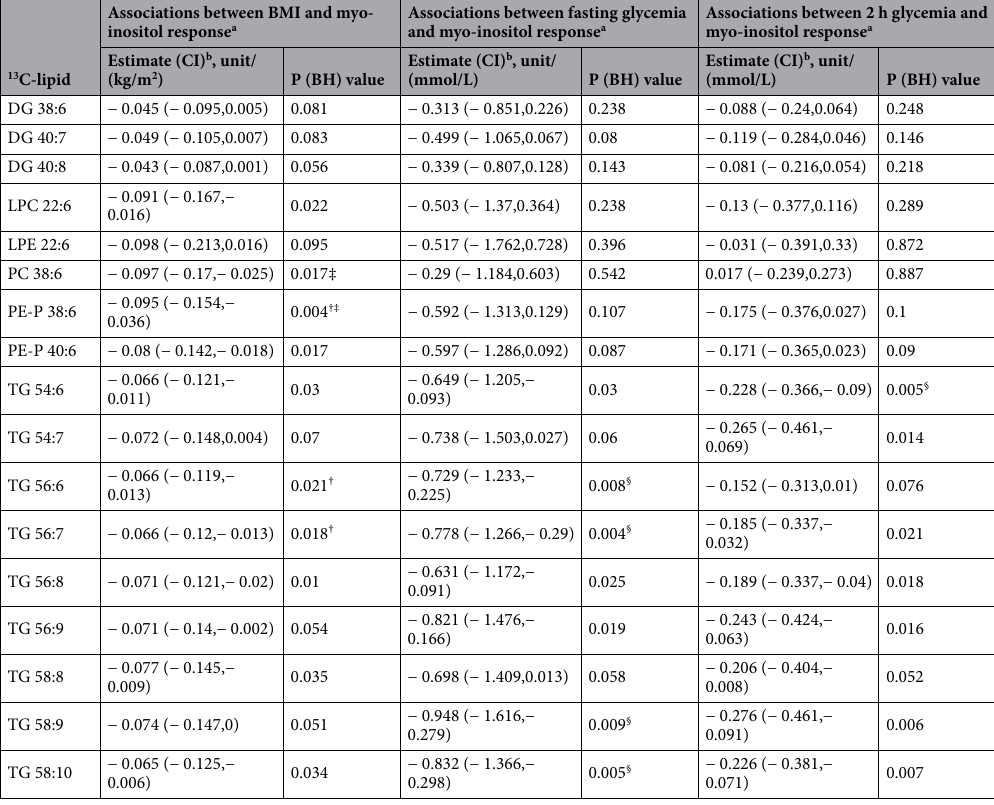
Table 1. Associations between BMI or maternal glycemia (fasting, 2 h post-load) with 13 C-DHA lipid in response to myo-inositol treatment (myo-inositol response). DG: diacylglycerols, DHA: docosahexaenoic acid, LPC: lyso-phosphatidylcholine, LPE: lyso-phosphatidylethanolamine, PC: phosphatidylcholine, PE: phosphatidylethanolamine, PE-P: phosphatidylethanolamine plasmalogen, TG: triacylglycerol. † Statistically significant after adjusting for fasting glycemia, ‡ Statistically significant after adjusting for post-load glycemia (2 h), § Statistically significant after adjusting for BMI. a Myo-inositol response represents the relative amount of 13 C-DHA lipid in placental explants treated with myo-inositol (60 µmol/L) for 48 h compared with control explants from the same placenta not treated with myo-inositol. b Linear regression was run with myo-inositol response as the outcome. The Benjamini-Hochberg (BH) method was used to correct for multiple